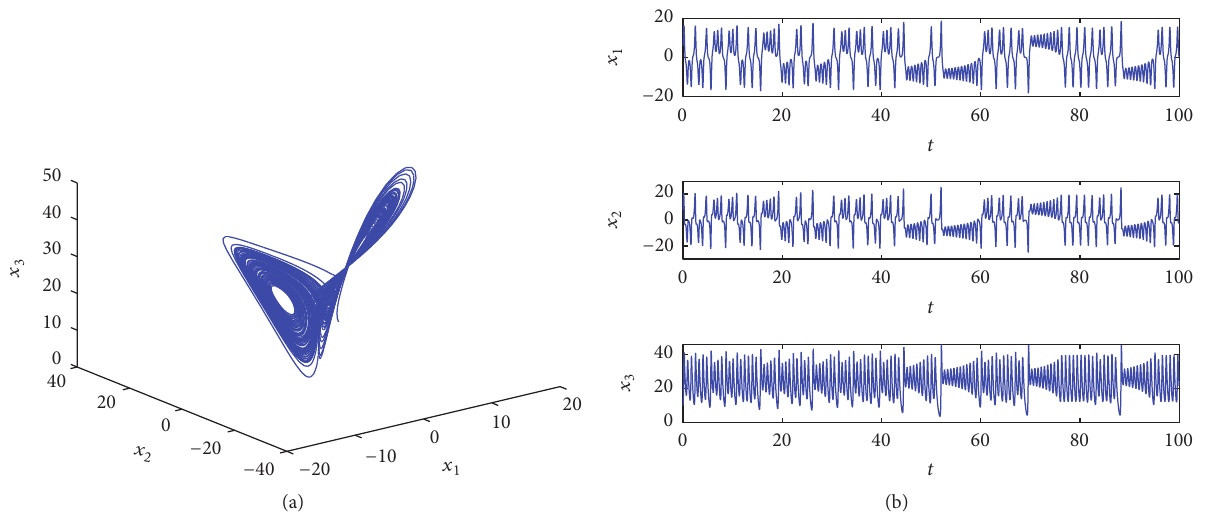
Figure 1: The dynamic behavior of system (44) with 𝜇 = 1/10 and (𝑥 1 (0),𝑥 2 (0),𝑥 3 (0)) = (6, 8,10) . (a) The chaotic attractor of system (44). (b) The state trajectories of system (44).